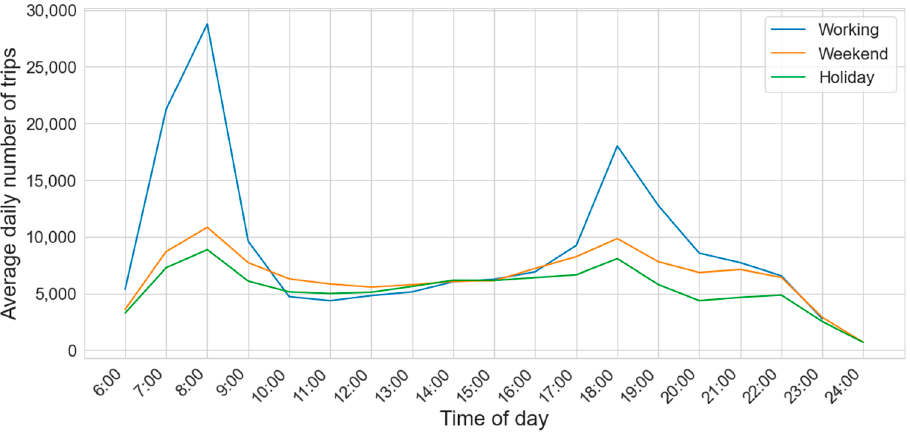
Figure 7. Average daily ridership of DBsMIC by hour. Figure 8 analyzes the hourly distribution of access use and egress use for DBsMIC on both weekdays and rest days. The analysis shows that access use and egress use on week- the morning peak for access use occurs one hour earlier than the morning peak for egress use, which is also in line with the pattern of residents using the metro for commuting.